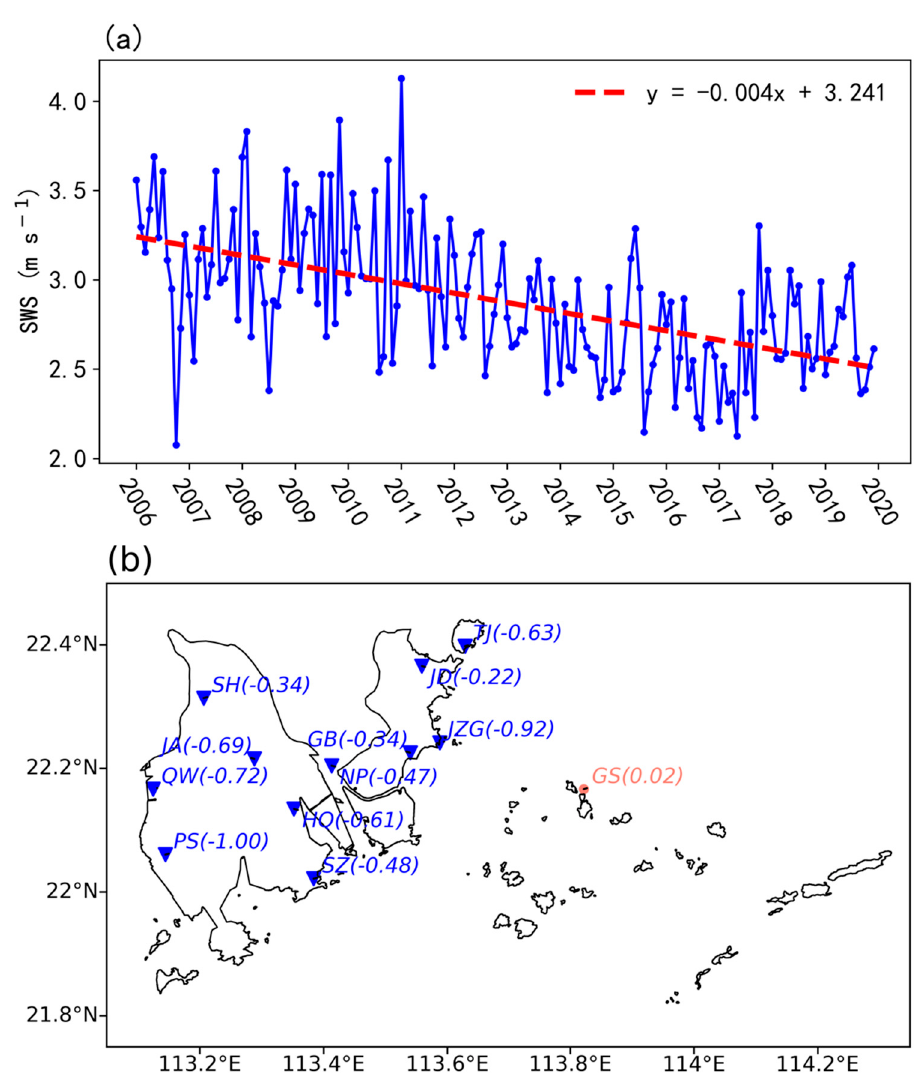
Figure 3. ( a ) Inter-annual variations of monthly SWS (m s − 1 ) averaged over Zhuhai during 2006–2020, with the black dashed line denoting the fitted line. ( b ) Geographic distribution of the decadal trend (m s − 1 per decade, in brackets) of monthly SWS over Zhuhai.